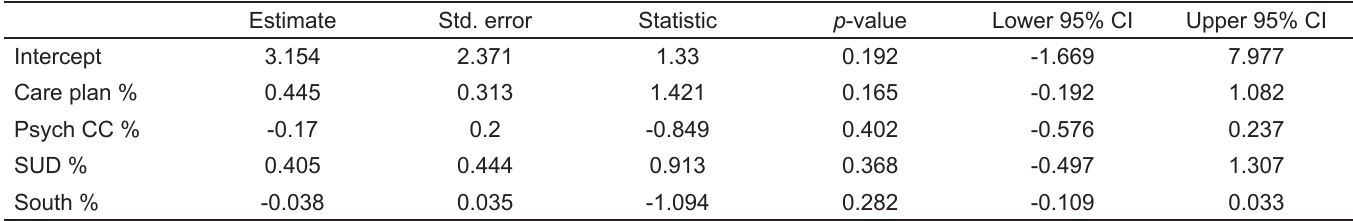
Table 1. Results of multiple linear regression model evaluating the impact of percentage of patients seen with complex care plans, and psychiatric or substance use disorder chief complaints and the percentage of shifts on a resident’s belief in a just world for others.